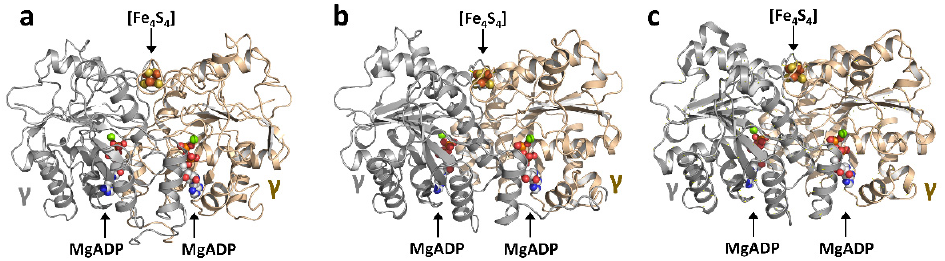
Figure 6. The homologous Fe proteins from Mo-, V-, and Fe-only nitrogenases. Crystal structures of the MgADP-bound forms of ( a ) NifH (PDB entry 6n4l), ( b ) VnfH (PDB entry 6q93) and ( c ) AnfH from A. vinelandii (PDB entry 7qqa). The subunits, clusters, and MgADP are presented and colored as those in Figure 1.